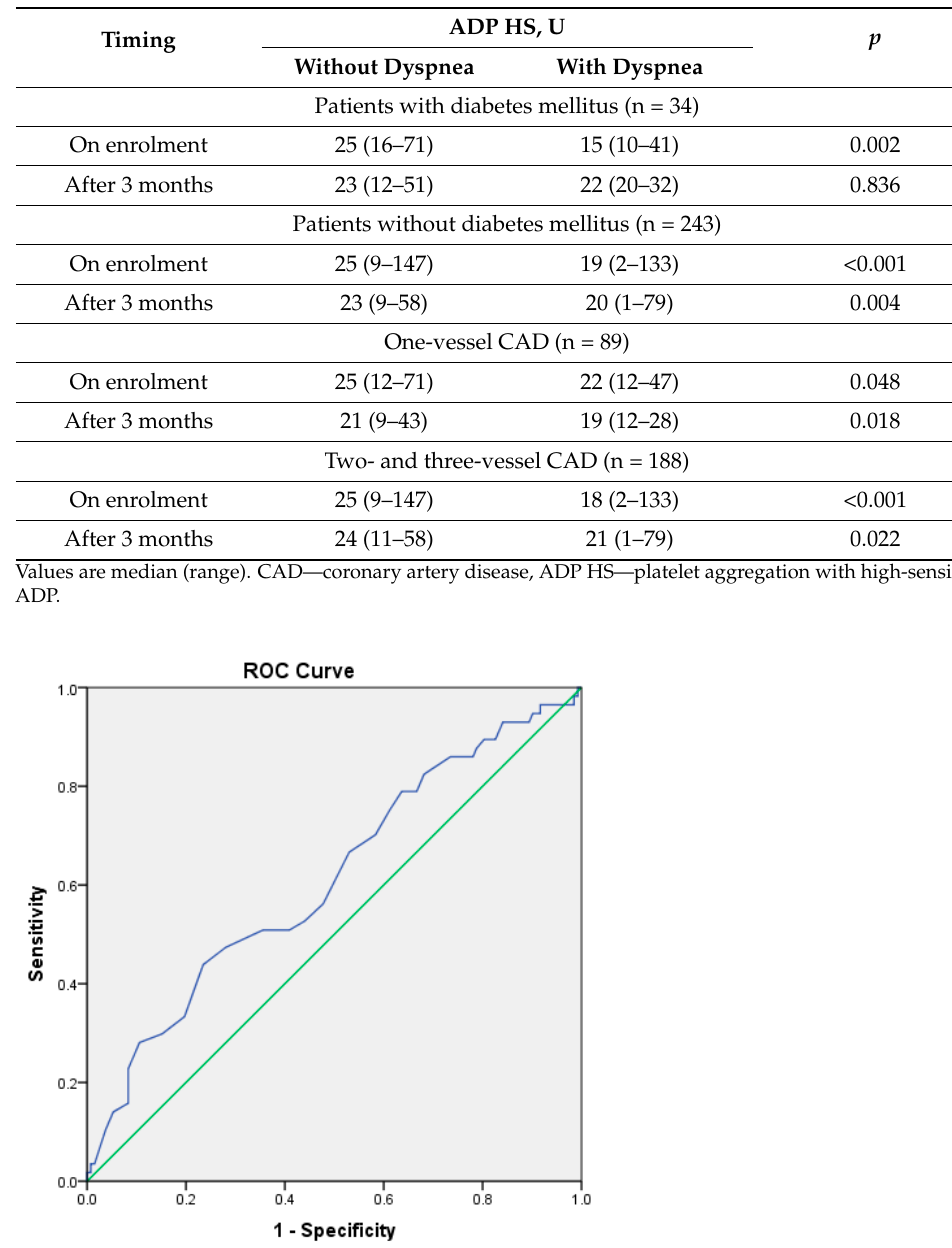
Table 5. Associations between the results of ADP HS testing and dyspnea.